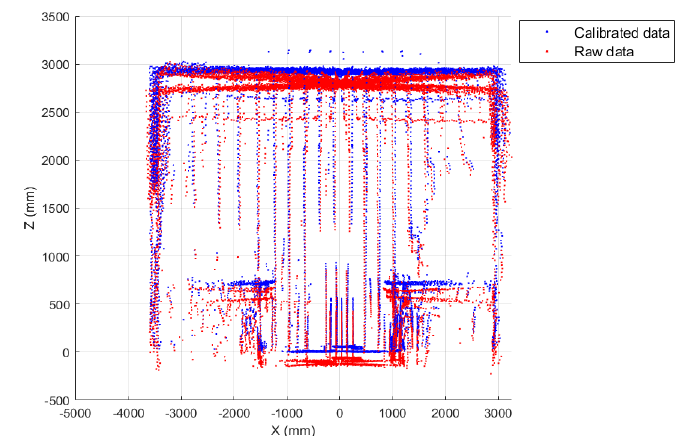
Figure 18. Comparison between raw and calibrated data (xz-plane).